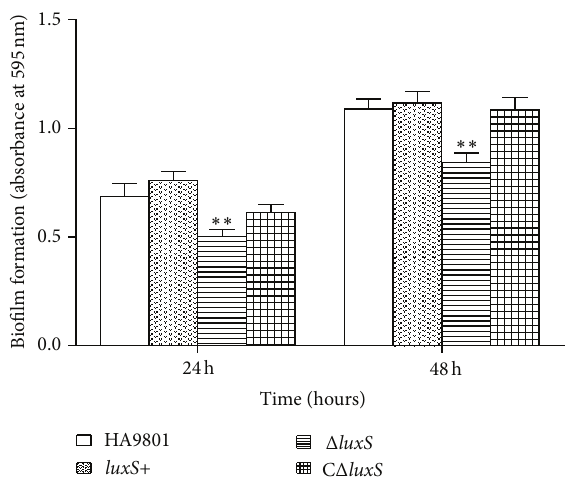
Figure 4: Quantitative determination of biofilm formation of the different strains. All strains were cultured in THB medium supplemented with 1% fibrinogen. Each strain was tested in 8-wells of a 96-well microtiter plate. Time course of biofilm formation of the different strains for 24 h or 48 h. HA9801, Δ luxS , C Δ luxS, and luxS + refer to the WT strain, the luxS mutant strain, the complementation strain, and the overexpression strain. The biofilm formation by the Δ luxS was significantly decreased compared to that of the WT strain ( 𝑃 < 0.01 ). The luxS + overexpression strain was slightly increased to those of the WT strain and C Δ luxS. Negative control (NC) wells contained broth only. The columns represent the means and standard deviations of four or more experiments. The asterisk showed significant difference ( 𝑃 < 0.05